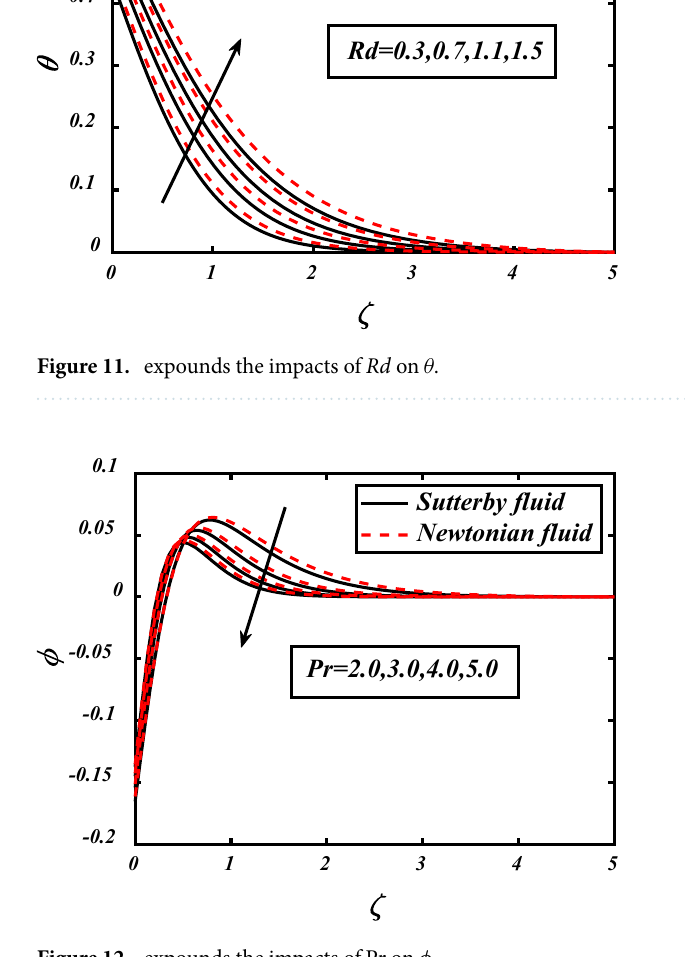
Figure 12. expounds the impacts of Pr on φ .